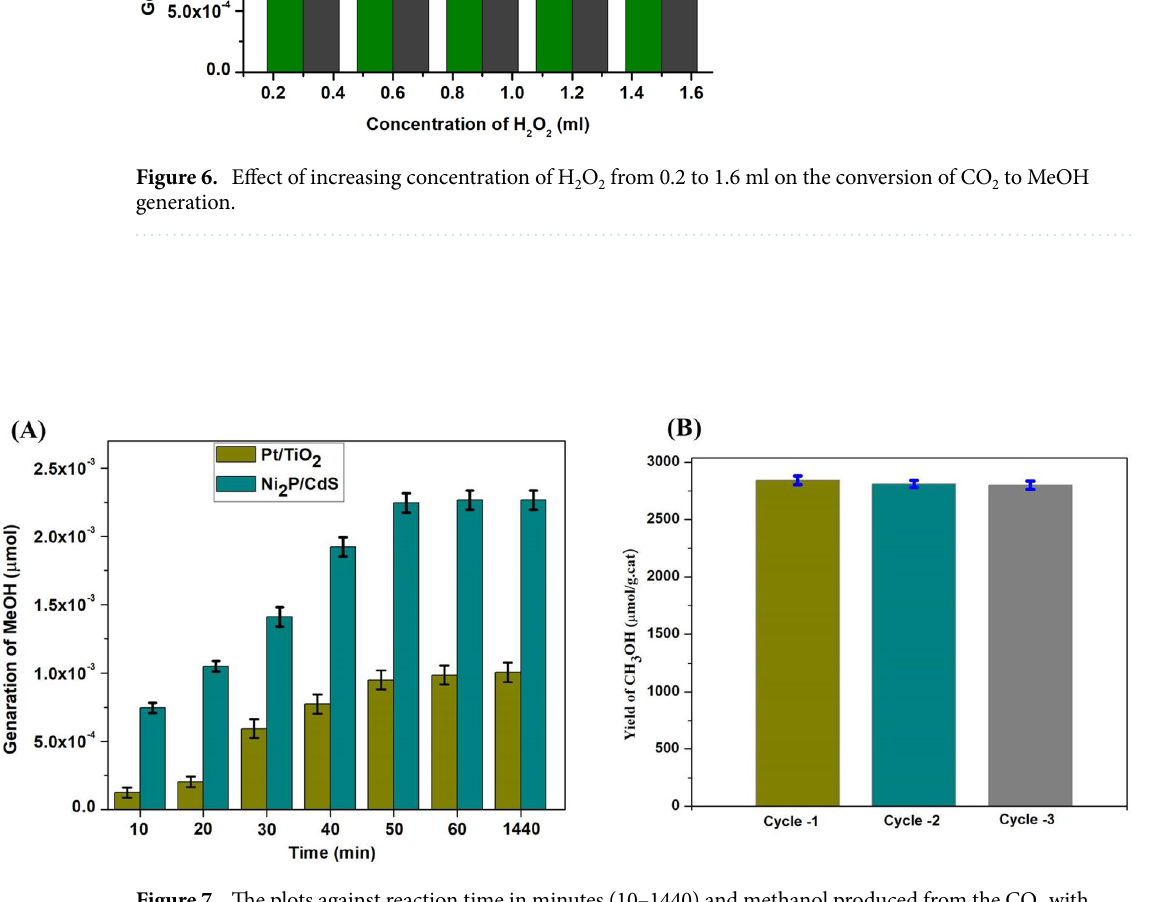
Figure 7. The plots against reaction time in minutes (10–1440) and methanol produced from the CO 2 with catalyst Ni 2 P/CdS and Pt/TiO 2 ( A ) and reproducibility of catalyst Ni 2 P/CdS for 3 cycles at 1 h time ( B